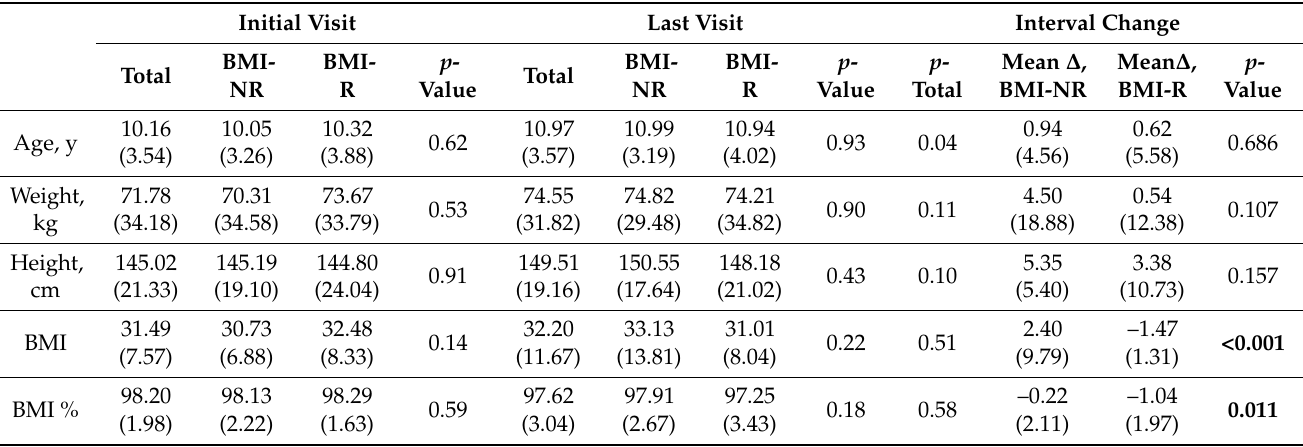
Table 1. Treatment Effect by